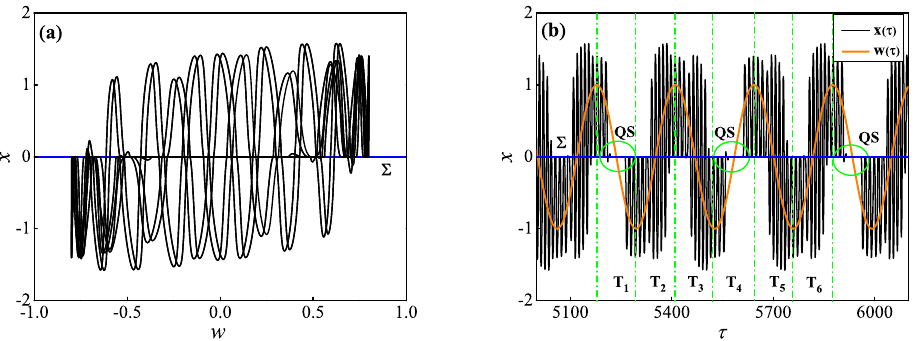
Figure 7. The redrawn MBOs when Ω = 0.027. ( a ) Phase portrait in ( w , x ) plane; ( b ) the superimpo- sition of time history of fast variable x and the time history of slow variable w